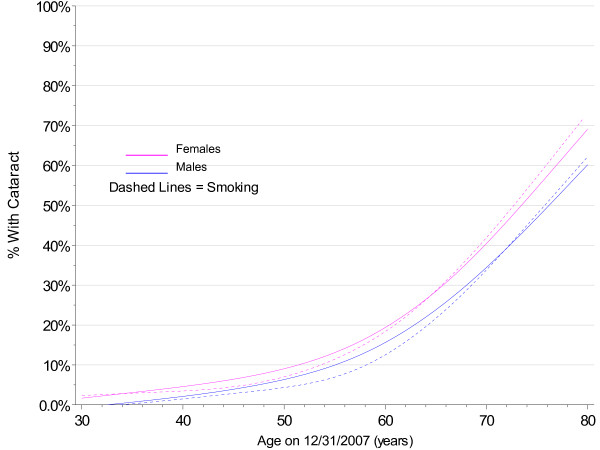
Smoothed 2007 Prevalence of Cataract by Gender and Smoking Cohort with No Diabetes.